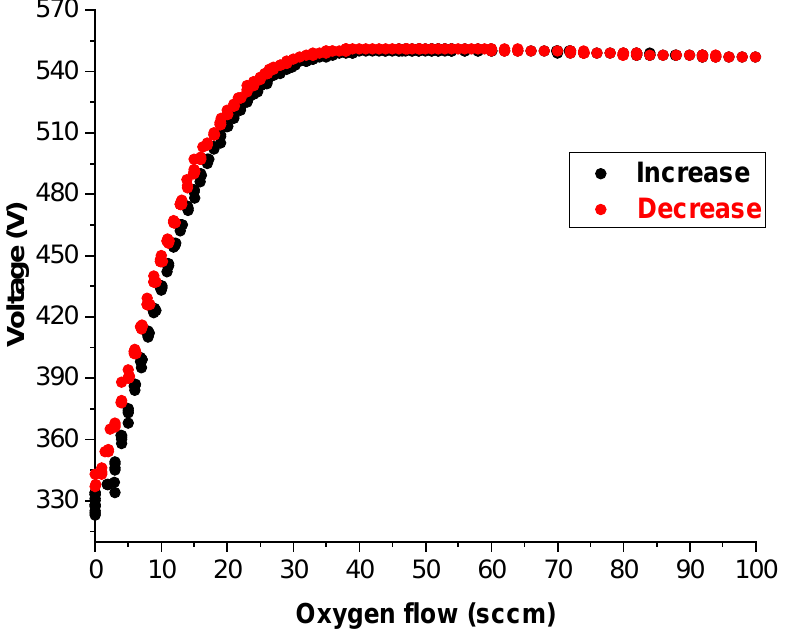
Figure 9. Hysteresis curve of W target manually acquired by varying oxygen gas flow.